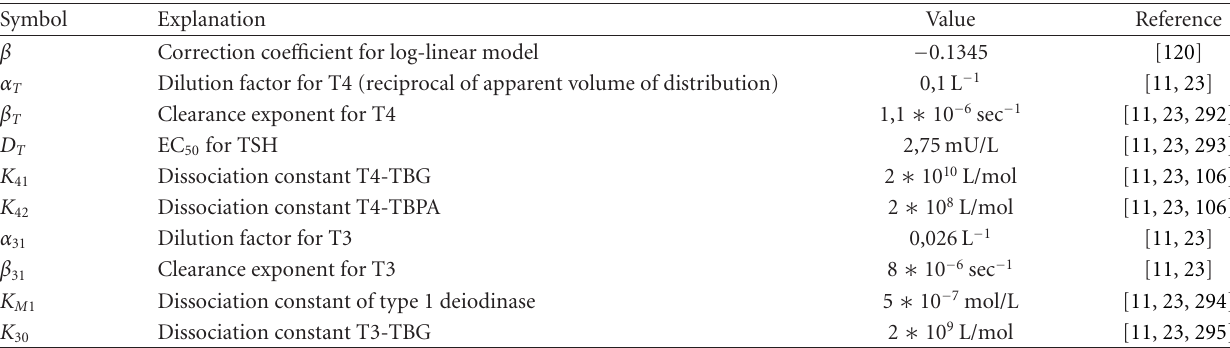
Table 2: Constant parameters for diagnostic calculations.